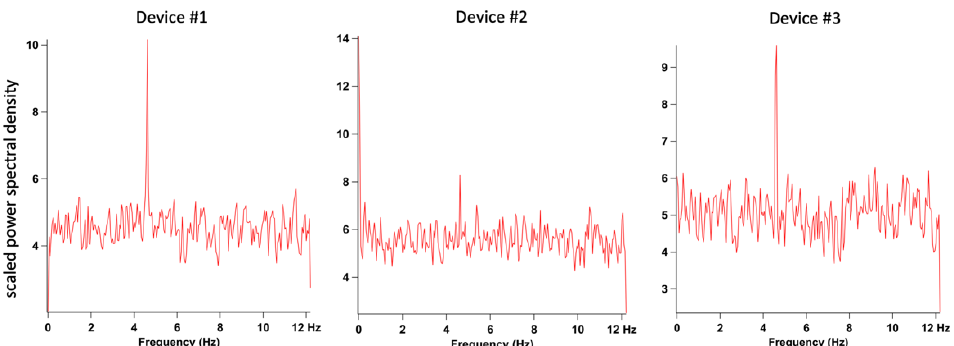
Figure 7. Noise power spectra for three individual dust sensors. All dust sensors indicated presence of interference noise of approx. 4.6 Hz. The origin of this noise is unknown. Other than this sole interfering frequency, noise approximated a white spectrum, suggesting signal averaging will improve signal-to-noise ratio.